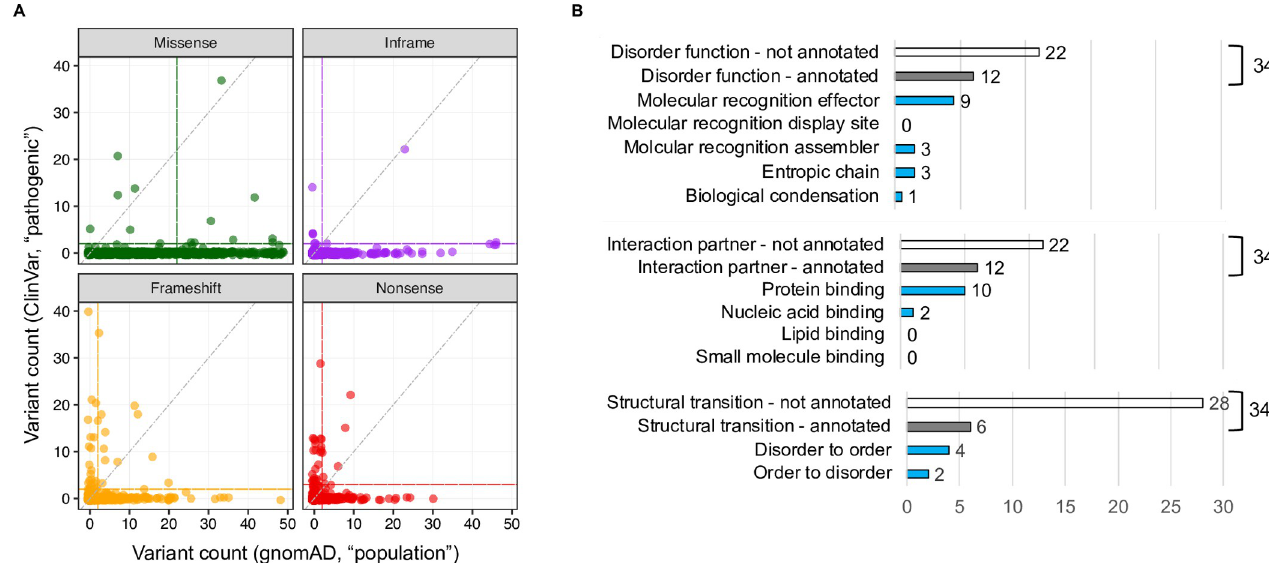
Fig 4. Identification of mutation-intolerant IDRs and their categories. ( A ) Number of population variants from gnomAD (x-axis) compared to the number of pathogenic variants from ClinVar (y-axis) for each IDR. The scatter plots are generated separately for four different types of mutations. The vertical and horizontal lines in each plot show the median count of population and pathogenic variants of a type from all IDRs. Circles located to the left of the vertical line, above both the horizontal and diagonal lines correspond to the IDRs “intolerant” to a particular type of mutation (mutation-intolerant IDRs). Circles located to the right to the vertical line, and below both the horizontal and diagonal lines correspond to the IDRs “tolerant” to a particular type of mutation (mutation- tolerant IDRs) In total, we identified 34 and 533 IDRs that are intolerant and tolerant to different types of mutation, respectively. ( B ) Number of mutation- intolerant IDRs (total = 34) of different categories in terms of disorder functions, interaction partners and structural transitions. Hollow and solid (gray) bars correspond to total mutation-intolerant IDRs that are not-annotated and annotated (with a category), respectively. Blue-colored solid bars represent mutation- intolerant IDRs with known function, interaction partners and structural